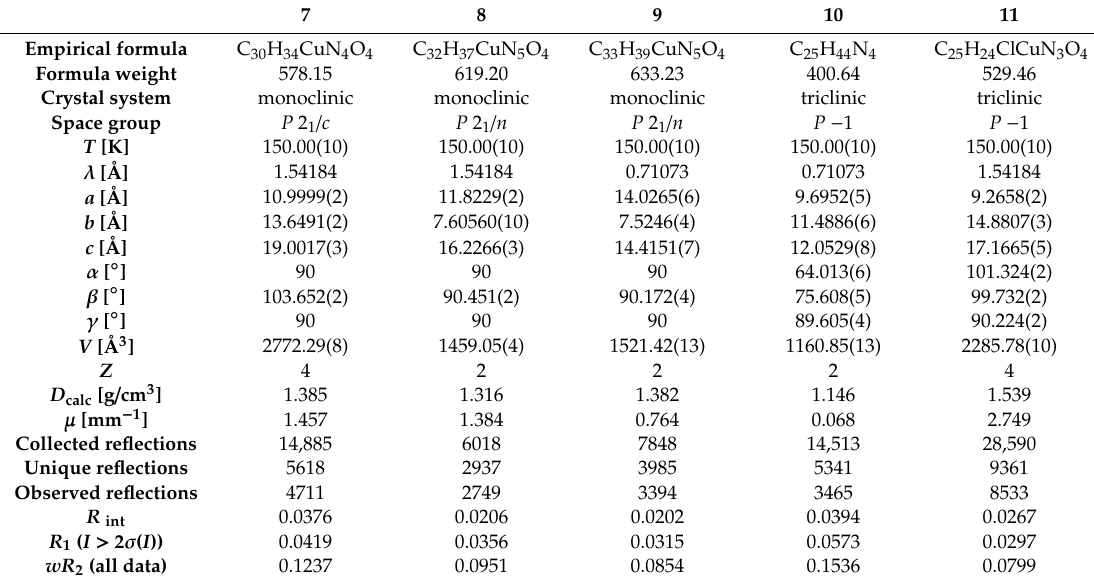
Table 4. Crystallographic data for 7 to 11